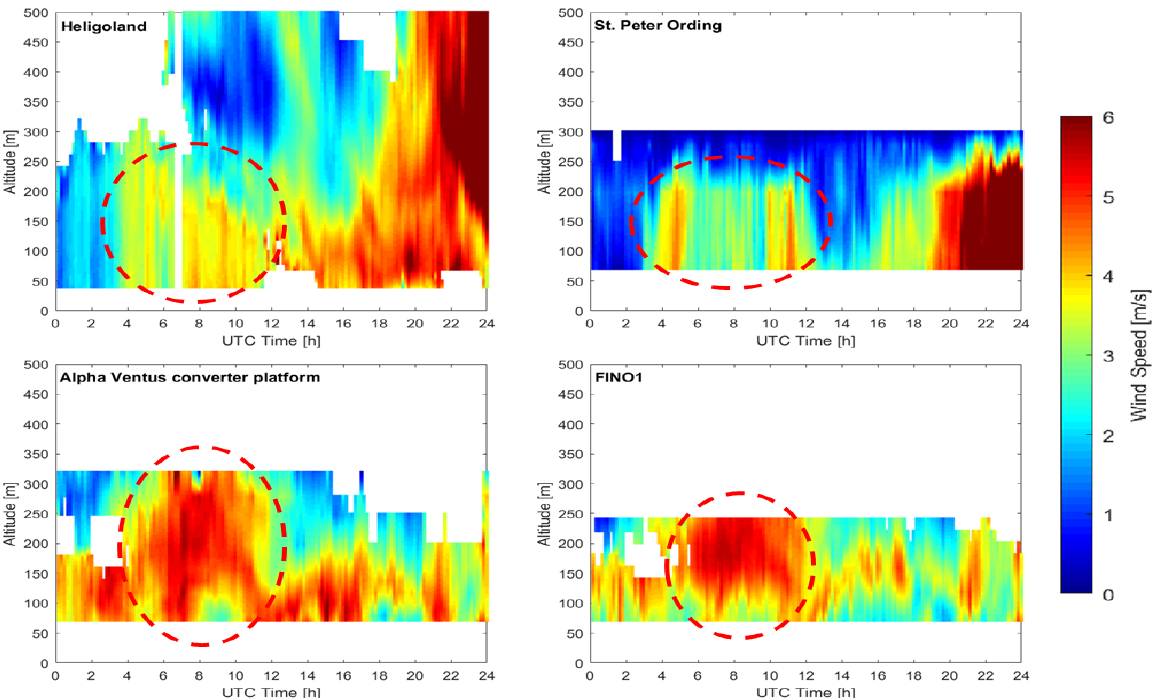
Figure 9. Time series of the lidar wind profiles for the sites Heligoland, St. Peter-Ording, Alpha Ventus and FINO1 on 2 June 2017. The locations of the wind lidar systems are provided on the map (Figure 1). The LLJ event (marked in red) during the time of the measurement flight is visible at all sites.